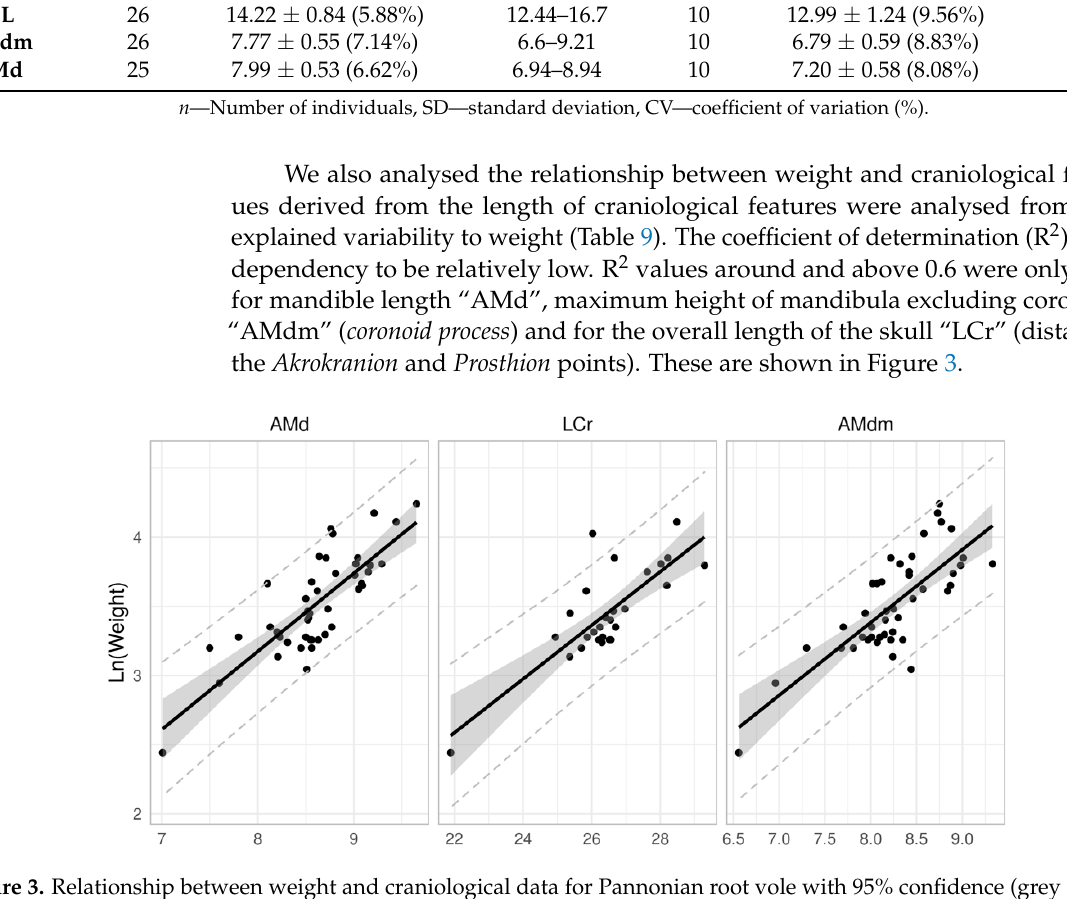
Figure 3. Relationship between weight and craniological data for Pannonian root vole with 95% confidence (grey area) and 95% prediction intervals (dashed lines) .